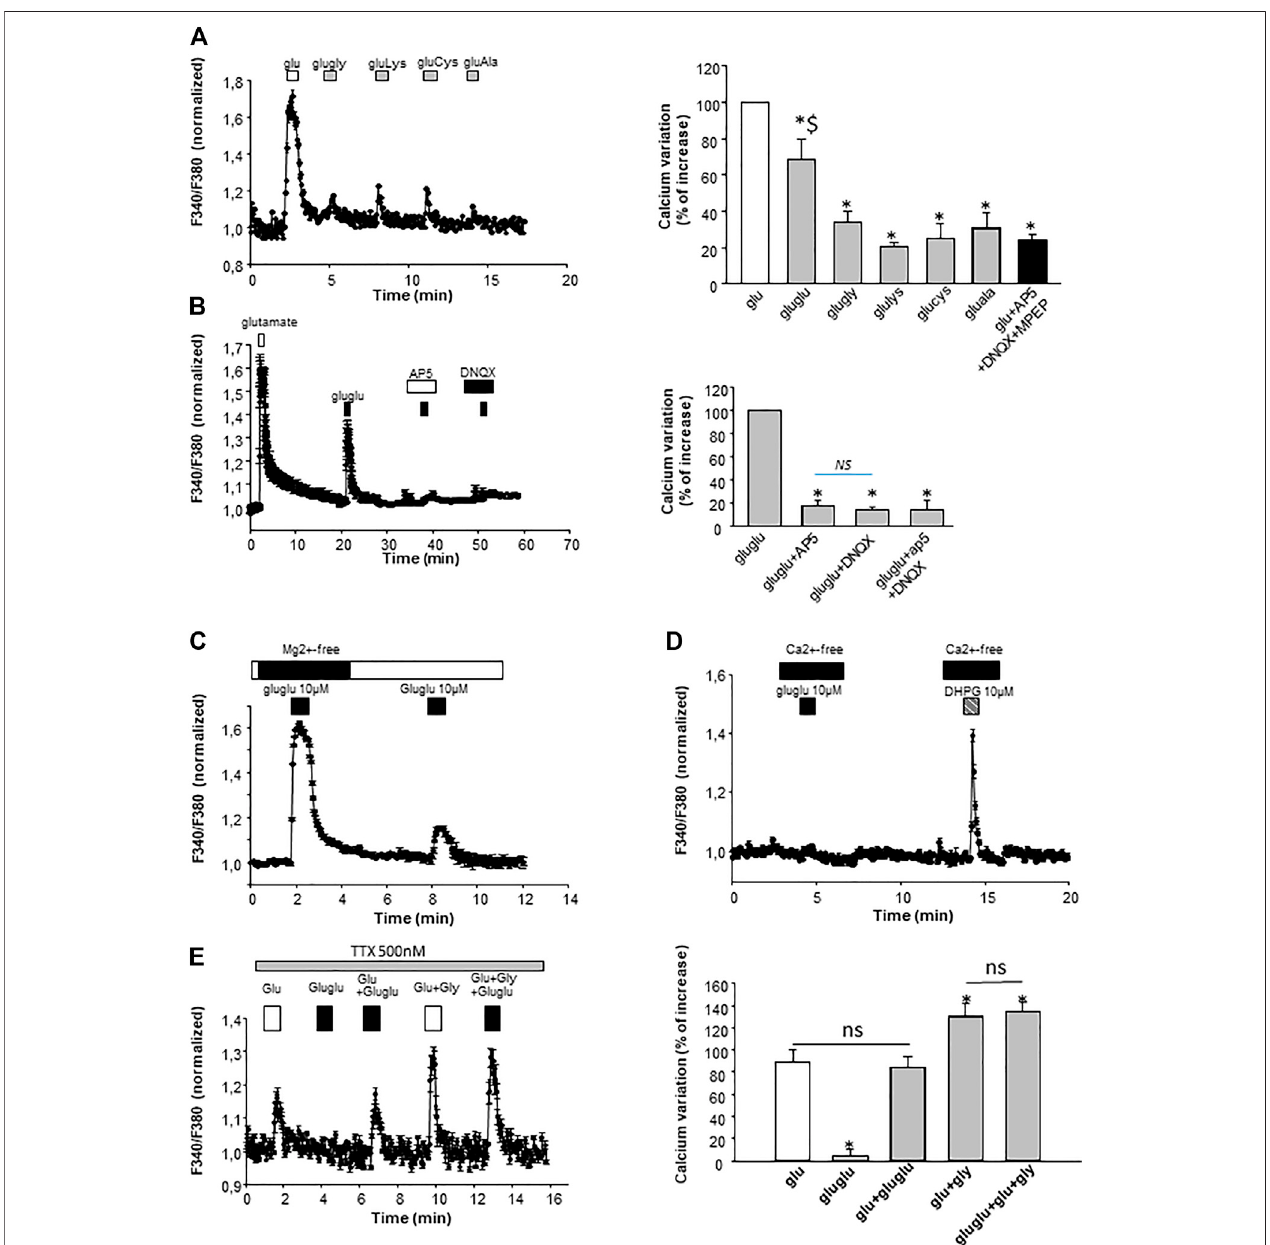
FIGURE1| Characterizationonthe γ -Glu-AAeffecton[Ca 2+ ] i inculturedneurons. (A) γ -Glu – Gly, γ -Glu – Lys, γ -Glu – Cys,and γ -Glu – Alaweresequentiallyappliedat 10 µM on cultured neurons. On the left, an illustrative sample trace obtained by averaging [Ca 2+ ] i changes recorded in the three cells is shown. On the right, the recapitulativegraphplotpeak[Ca 2+ ] i normalizedtoglutamateresponse(at10 µM;100%)forallthe γ -Glu-AAtested( n (cid:1) 75).* p < 0.05whencomparing γ -Glu-AA- vs the Glu-elicitedresponse;$ p < 0.05whencomparing γ -Glu-Glu- vs other γ -Glu-AA – elicitedresponses. (B) Pharmacologicalcharacterizationof γ -Glu-Glutargetswith glutamate ionotropic receptor antagonists AP5 (25 μ M; NMDAr antagonist) and DNQX (10 μ M; AMPAr and KAr antagonist). On the left, a graph plotting averaged sample traces of the 27 cells recorded during one individual experiment is shown. On the right, the recapitulative graph plot peak [Ca 2+ ] i normalized to γ -Glu-Glu response (at 10 μ M; 100%) for all the conditions tested ( n (cid:1) 193). (C) Illustrative experiment depicting the dependency of γ -Glu-Glu – elicited [Ca 2+ ] i increase on the presence of Mg 2+ ions in the extracellular medium. The graph was obtained by averaging traces recorded in the 30 individual cells. (D) Representative experiment illustrating the dependency of γ -Glu-Glu effects on the extracellular Ca 2+ ions. The metabotropic glutamate receptor (mGlu5) agonist DHPG (10 µM) was tested as a control for the stimulation Ca 2+ release from intracellular stores. The graph has been generated by averaging the responses of 25 individual cells recorded. (E) Effect of TTX of γ -Glu-Glu – elicited responses. On the left, a graph plotting the responses of Glu and γ -Glu-Glu is shown. It has been obtained by averaging [Ca 2+ ]i changes from 12 individual cells recorded during a single experiment. On the right, the graph recapitulates the [Ca 2+ ]i increases elicited by Glu, γ -Glu-Glu, Glu+ γ -Glu-Glu, γ -Glu-Glu + Gly, and Glu+ γ -Glu-Glu + Gly. Data are presented as [Ca 2+ ]i increases normalized to the responses of Glu ( n (cid:1) 68).